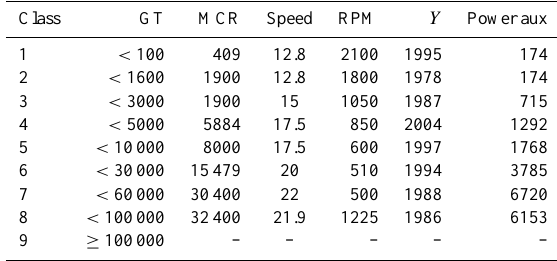
Table A5. Class medians for ferries.